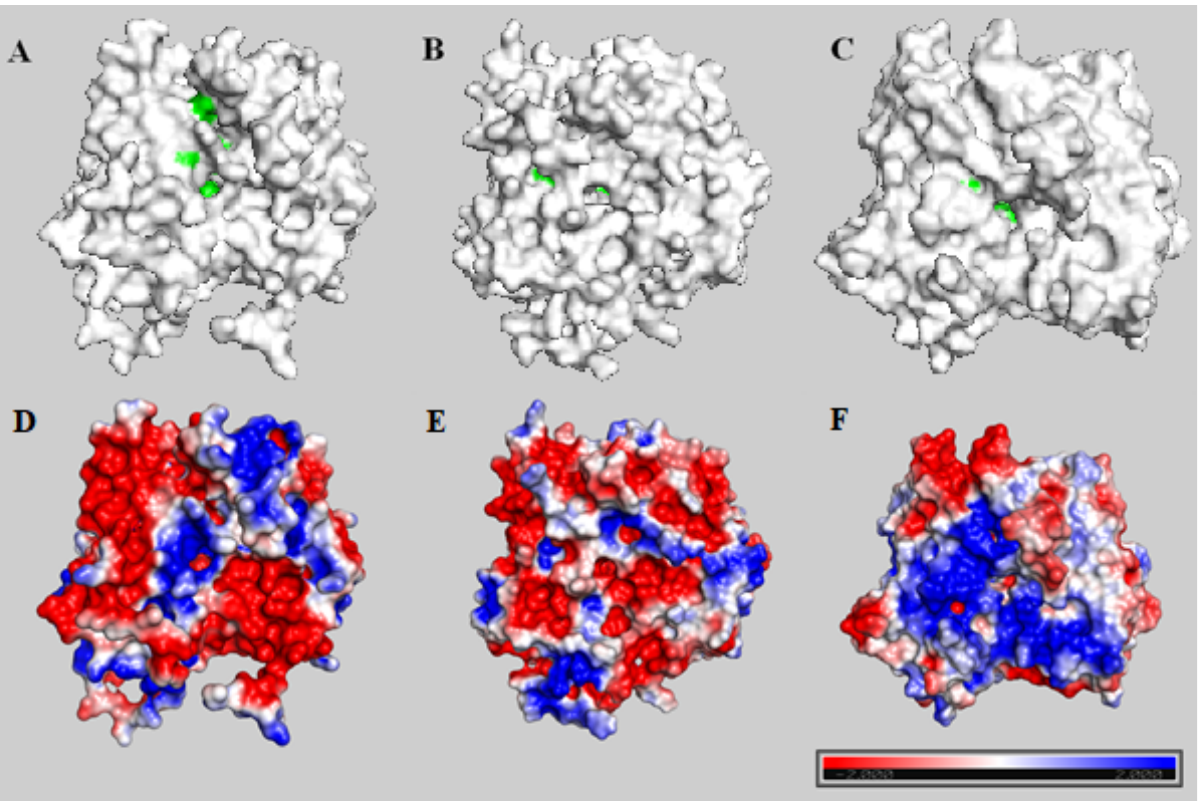
Figure 5 - Molecular surface of PhBPBT (A, D), PhCFAT (B, E), and PvHCT2a (C, F) indicating the active sites (green) and their electrostatic potential, respectively. The most negative residues were colored in red, the neutral in white, and the most positive in